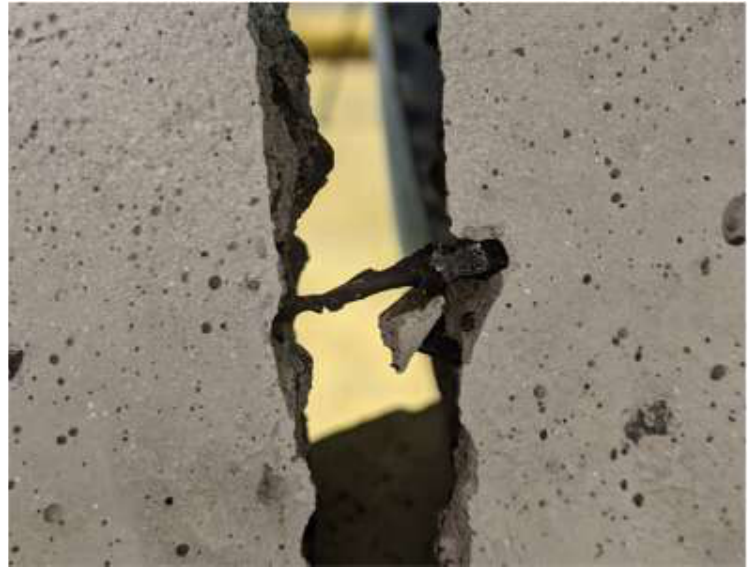
Figure 4. Crack bridging by tire shreds